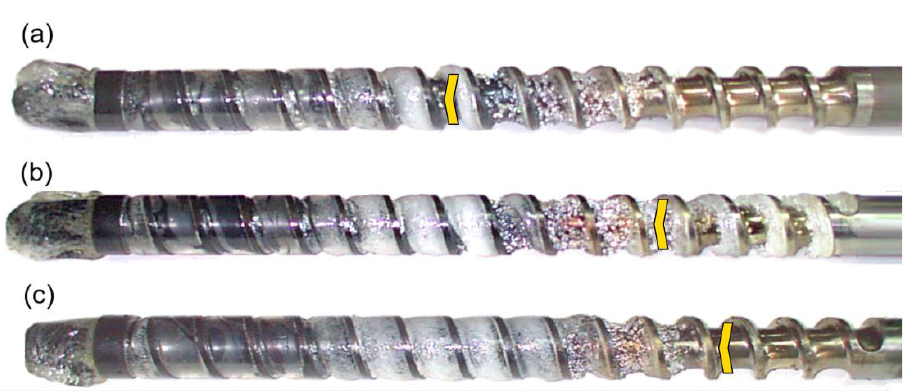
Figure 19. An effect of the back pressure on the polymer flow in the injection molding process at the screw speed N = 300 rpm, and the plasticating stroke h plast = 3 D: ( a ) P back = 0 MPa, ( b ) P back = 2 MPa, ( c ) P back = 3 MPa.